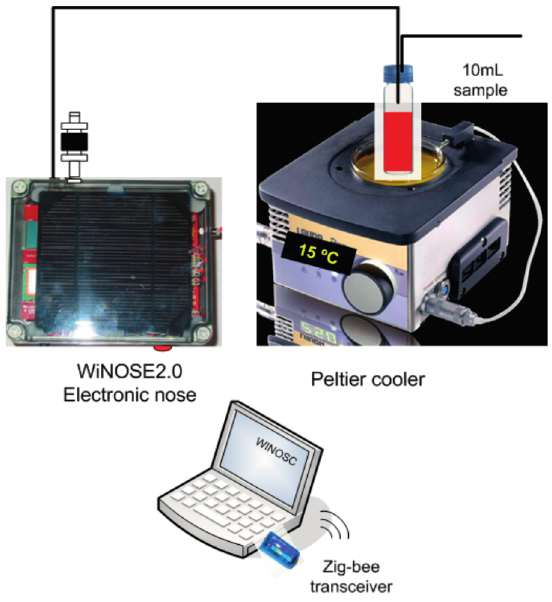
Figure 1. Experimental system of